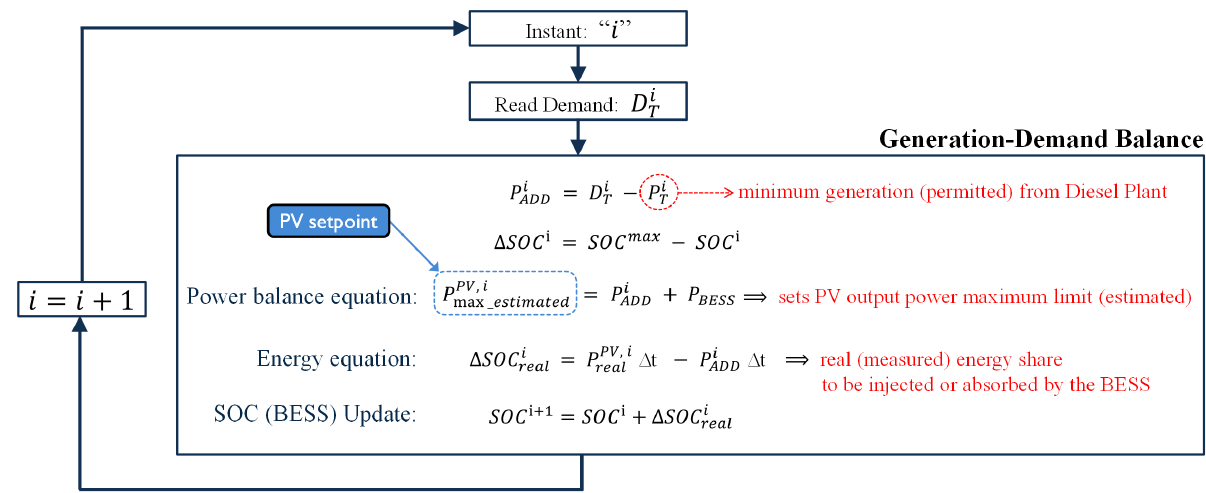
Figure 5. Discretized modeling of the ASC- µ Grid real time